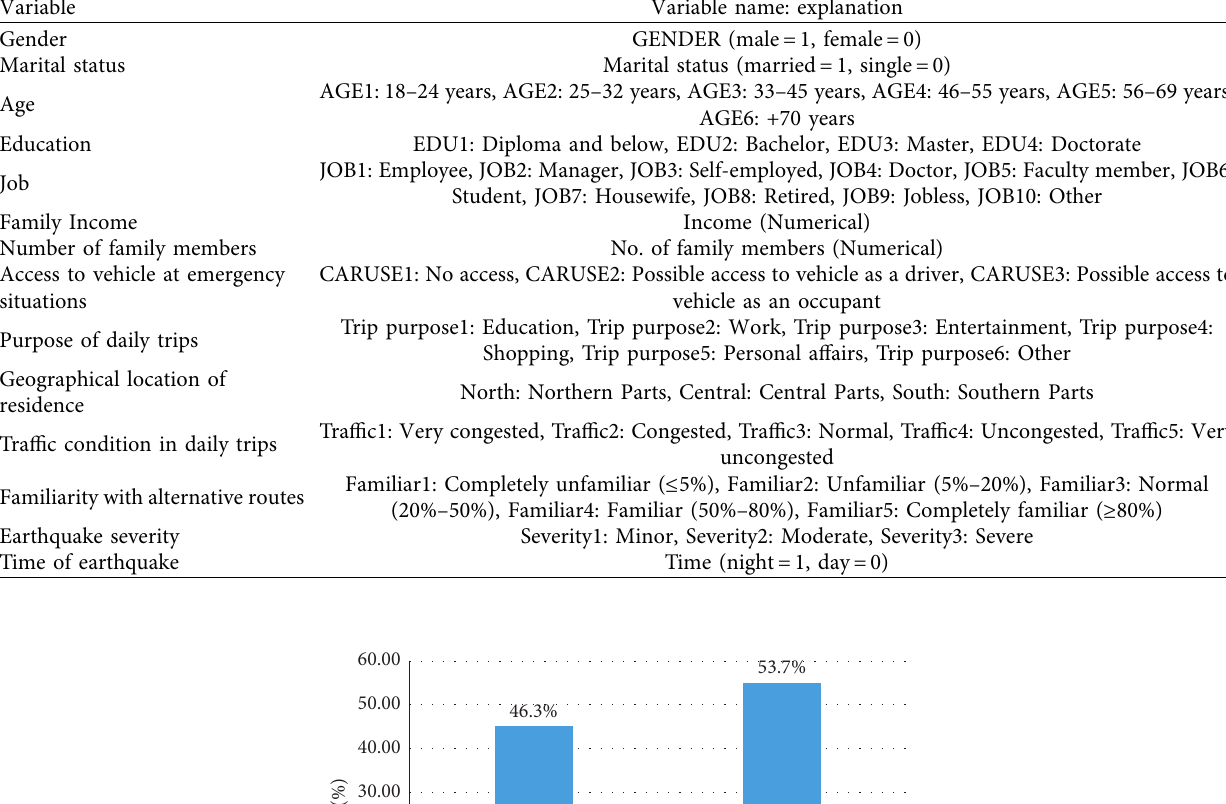
Table 5: Independent variables of modeling.